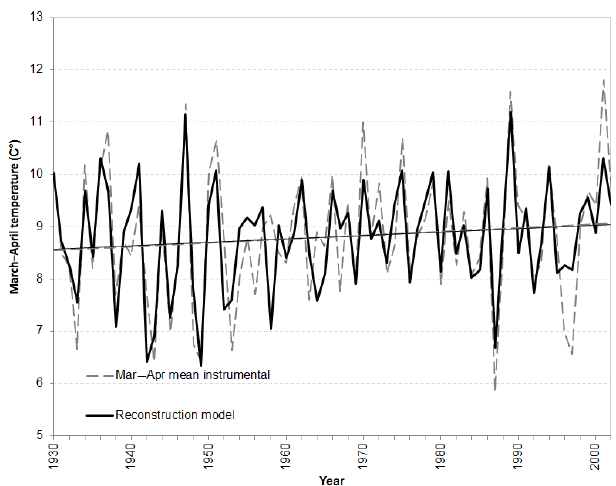
Figure 5. Actual (instrumental) and reconstructed March–April temperature ( ◦ C). Dashed gray lines represent actual values and solid black lines represent reconstructed values shown with trend lines. The tendency to warm up at the reconstructed temperature is in good agreement with the trend in instrumental data.